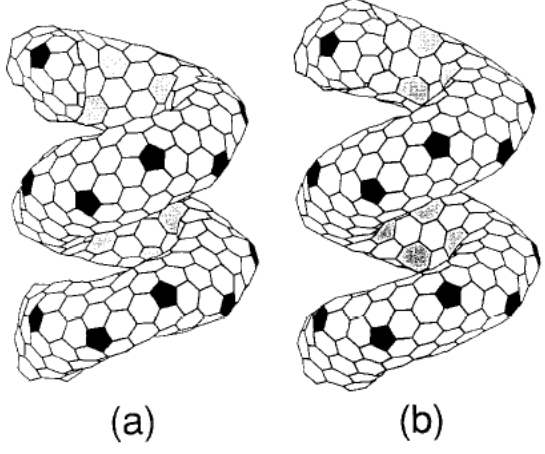
Figure 2. Helically coiled form C 360 : one pitch contains a torus C 360 . (a) coil length = 12.9 Å and, (b) coil length = 13.23 Å. The tiling pattern of heptagons in the inner ridge line is changed, though the pattern of pentagons in the outer ridge line remains upon changing the coil length. Reproduced from [30] with